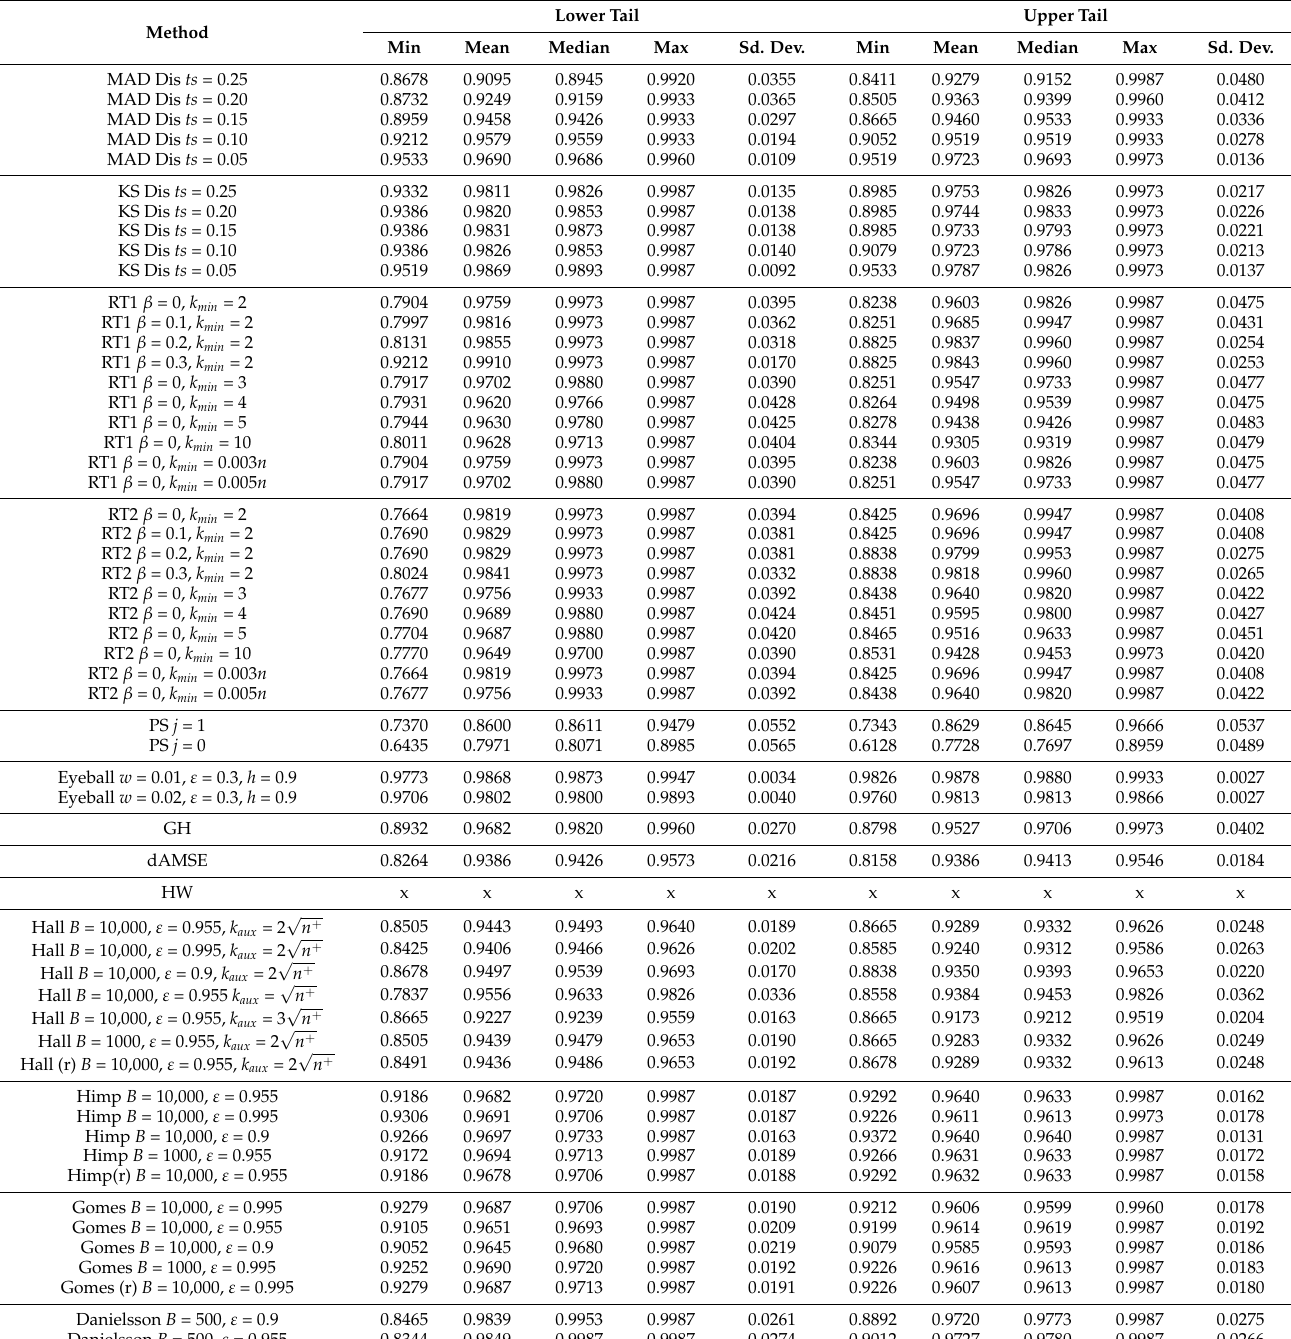
Table 4. Estimates of the threshold under different methods in the third